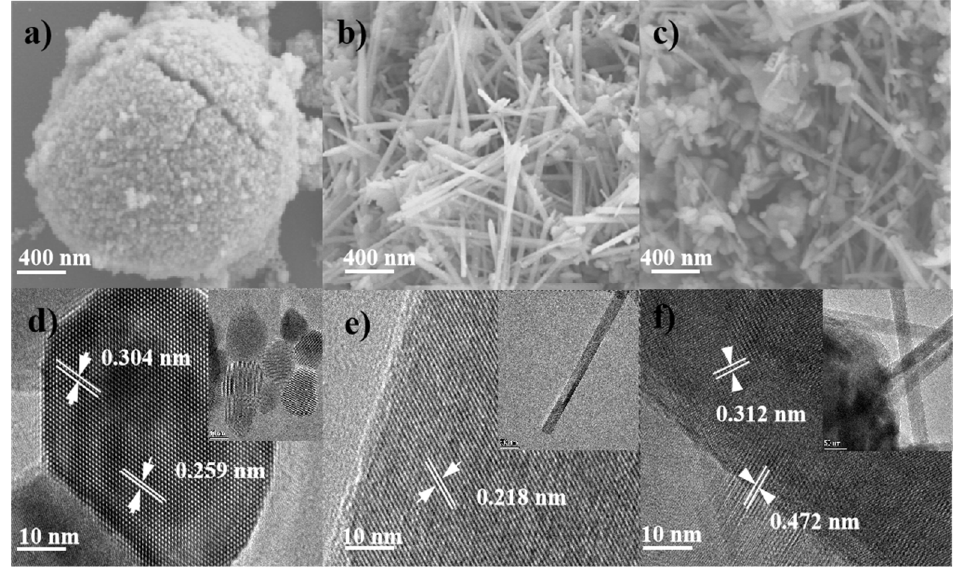
Figure 2. ( a ), EDS layered image of ZnO‐C/MnO 2 ( b ), Element distribution image of C, O, Zn, Mn ( c – f ).